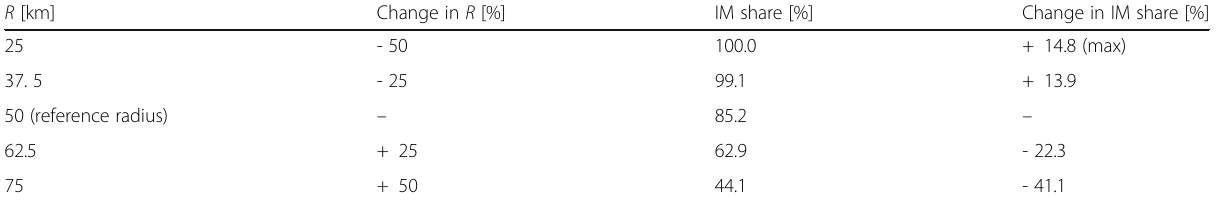
Table 3 Sensitivity analysis of intermodal share with regard to the radius of the market area ( s = 800 km) R [km]